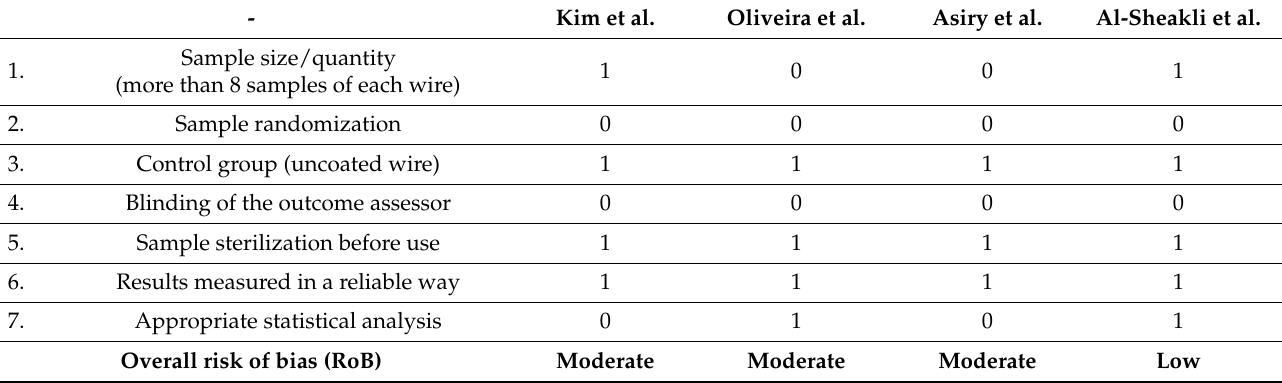
Table 3. The quality analysis of in vitro studies using an individual RoB quality assessment tool created by authors of the systematic review.